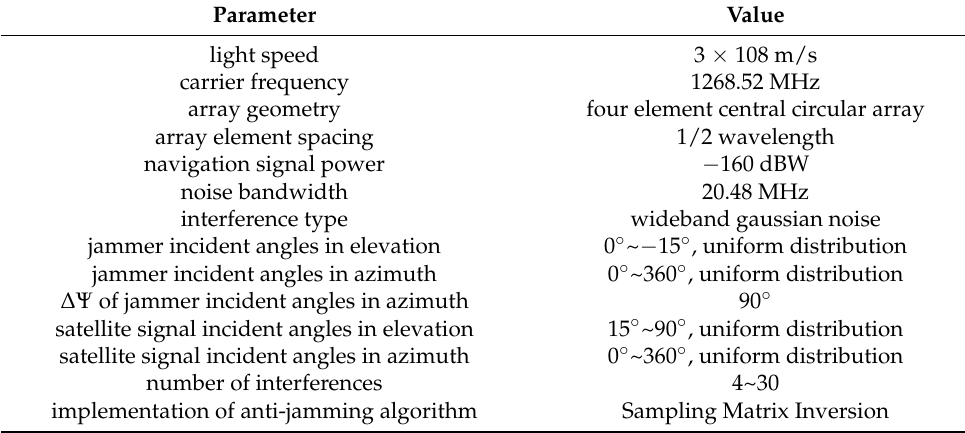
Table 3. Simulation parameters.